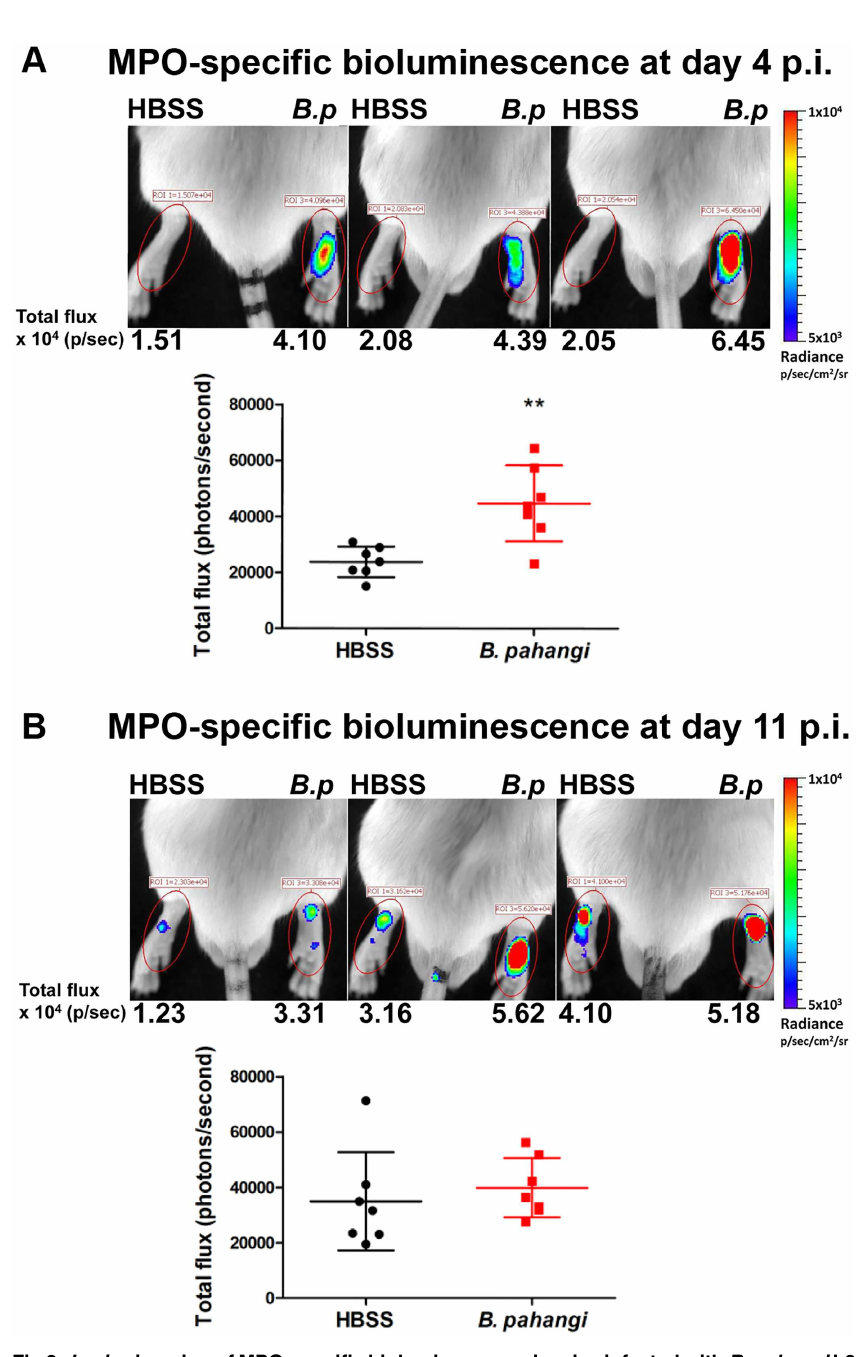
Fig 2. In vivo imaging of MPO-specific bioluminescence in mice infected with B . pahangi L3 larvae. BALB/c mice were injected with 50 L3 of B . pahangi into the RHS footpad ( B . p )and with HBSS into the LHS footpad. On day 4 ( A ) and day 11 ( B ) post-infection mice were imagedusing an IVIS spectrum 20 minutes after subcutaneous injectionof 200 mg/kg luminol. Representative images of 3 mice per group are shown. The colour scale indicatesbioluminescence radiancein photons/second/cm 2 /steradian. Graphs show the bioluminescence total flux (in photons/second) within the same footpad regionof interest (ROI, red ovals in images). Each symbol shows the total flux for a single mouse, lines indicate the means (n = 7 mice) and error bars show SD ( ** p < 0.01 using a Mann-Whitney